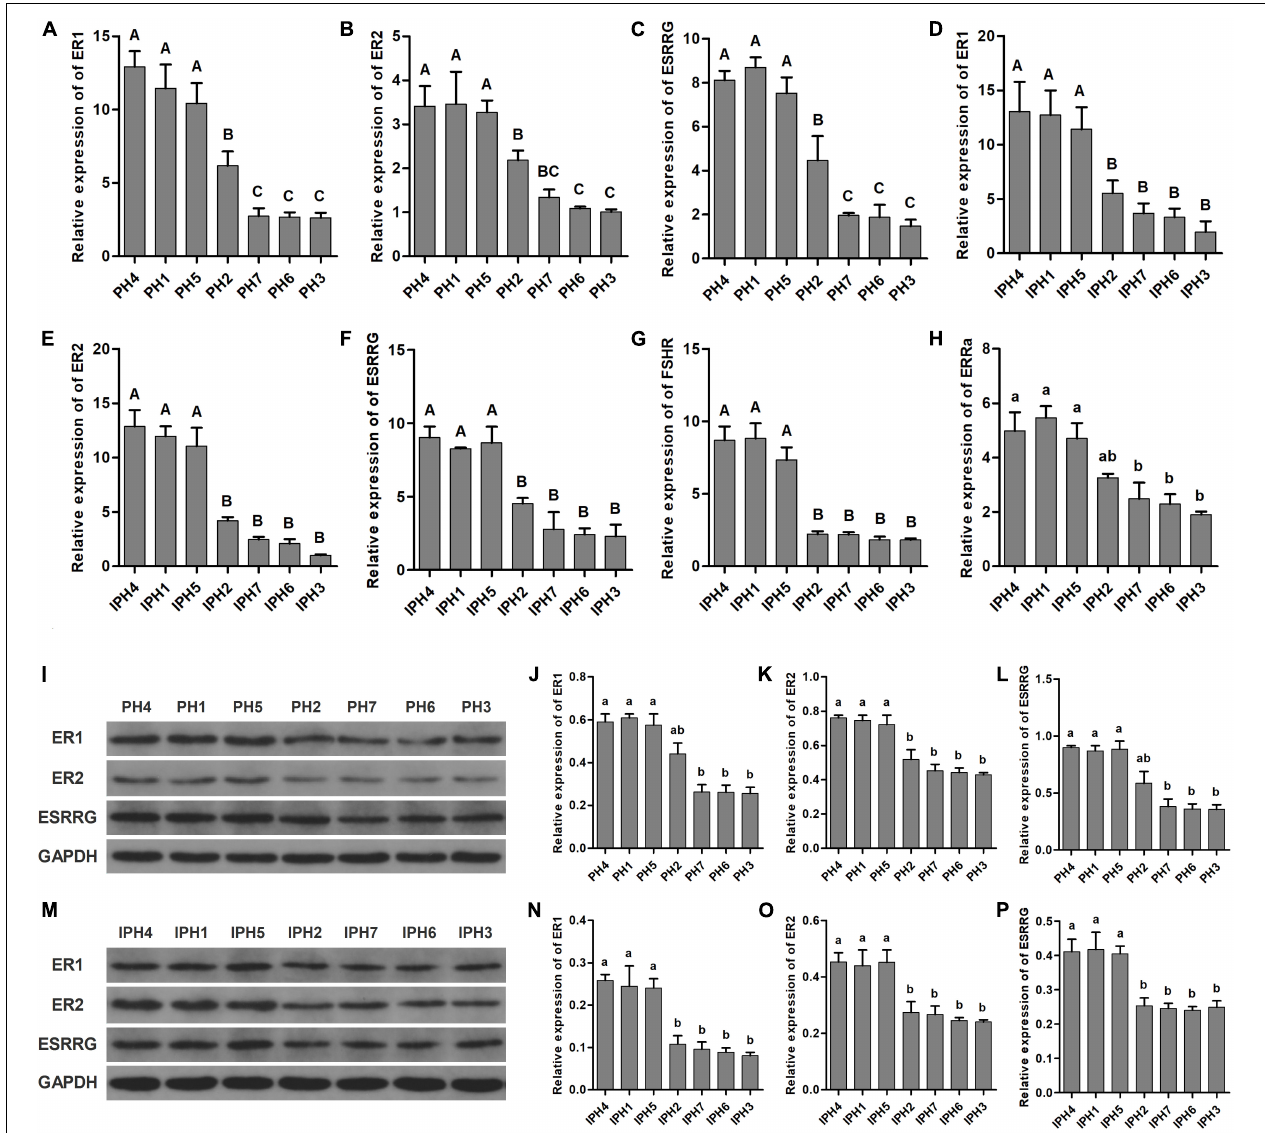
FIGURE 6 | Expressions of reproduction-related genes in fibroblasts and cybrids. (A–C) Illustrated the mRNA expressions of ER1 , ER2, and ESRRG in fibroblasts. (D–H) Presented the mRNA expressions of ER1 , ER2 , ESRRG , FSHR, and ESRRa in cybrids. (I,M) Illustrations of western blotting images in fibroblasts and cybrids. (J–L) Protein levels of ER1, ER2, and ESRRG in fibroblasts. (N–P) Protein contents of ER1, ER2, and ESRRG in cybrids. Different capital and lowercase letters on columns meant significant differences at P < 0.01 or P < 0.05, respectively. PH1-7, fibroblast with mitotype 1–7, respectively; IPH1-7, cybrid with mitotype 1–7,